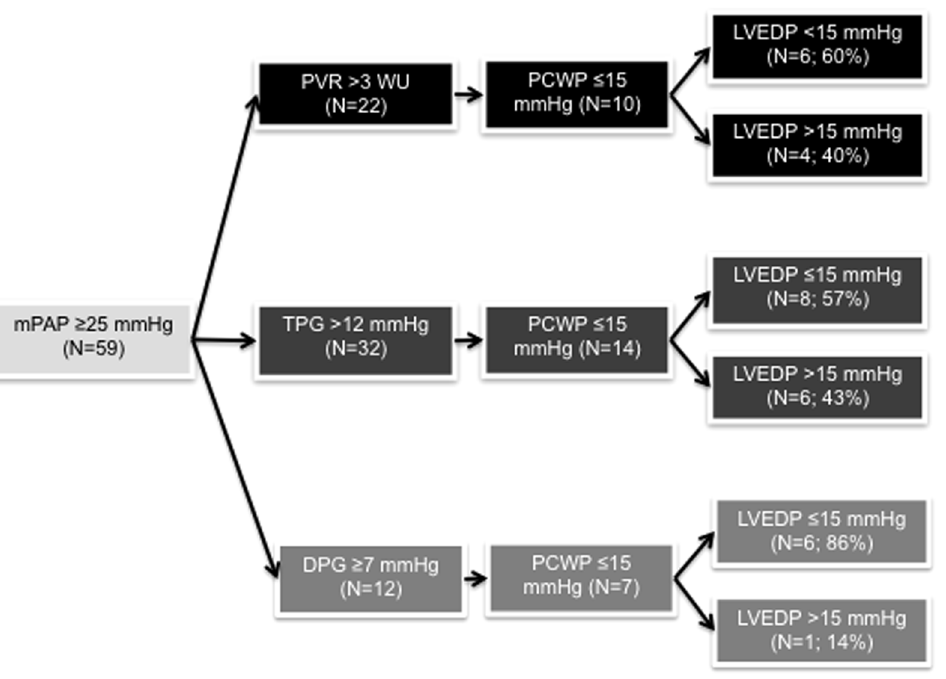
Figure 5. Distribution of patients with LVEDP # 15 mmHg or LVEDP . 15 mmHg in patients with PCWP # 15 mmHg and PVR . 3 WU (upper panel; black), TPG . 12 mmHg (middle panel; dark grey), or DPG . 7 mmHg (bottom panel; light grey). DPG, diastolic pressure gradient; PVR, pulmonary vascular resistance; TPG, transpulmonary gradient.